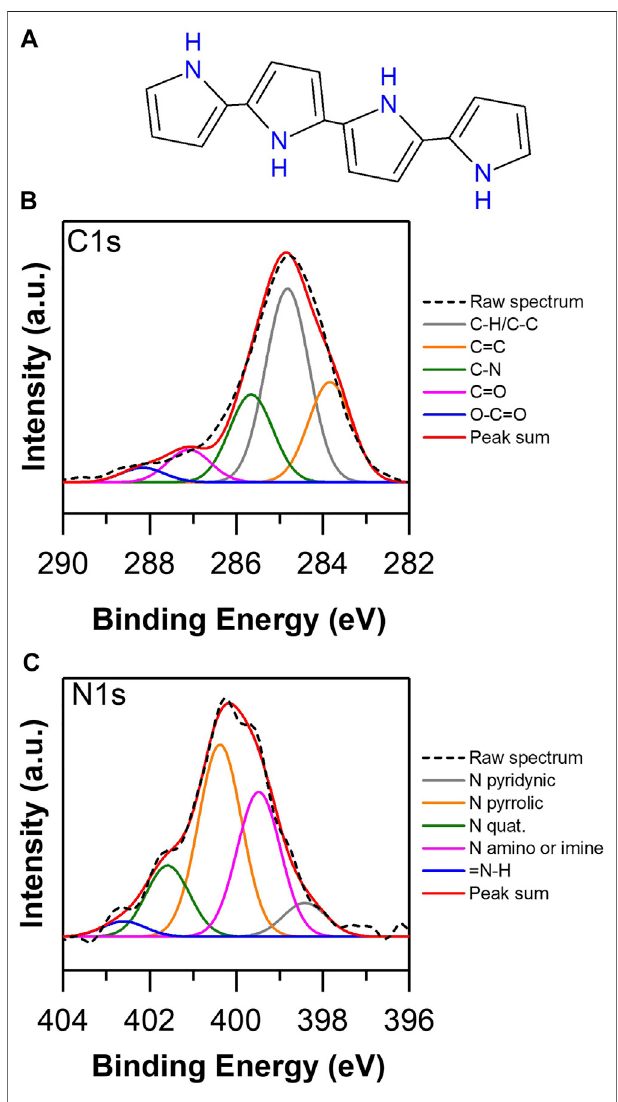
FIGURE 7 | (A) Structure of PPY. High resolution XPS spectra of biomimetically synthesized PPY TSA: (B) C 1s and (C) N 1s.